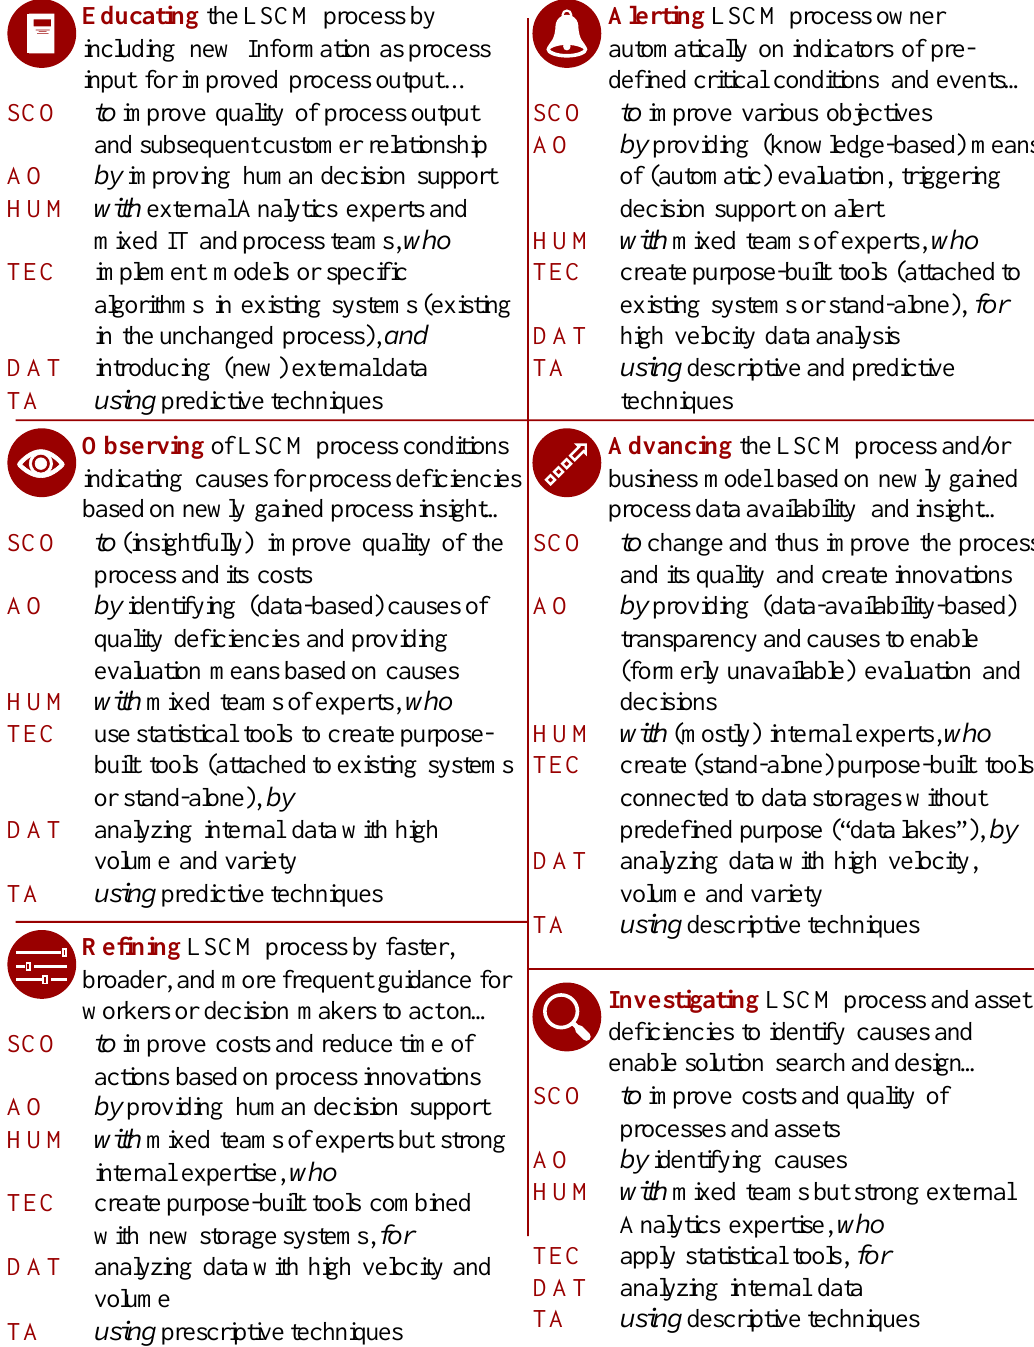
Figure 4. Proposed Supply Chain Analytics archetypes (no chronology or sequence intended).